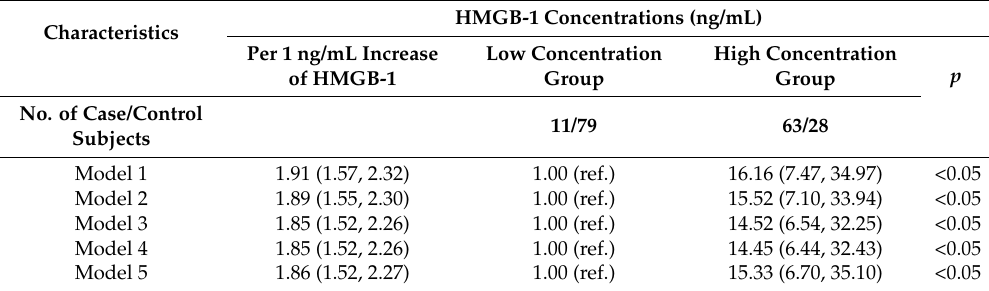
Table 2. The relationships between plasma HMGB-1 concentrations and